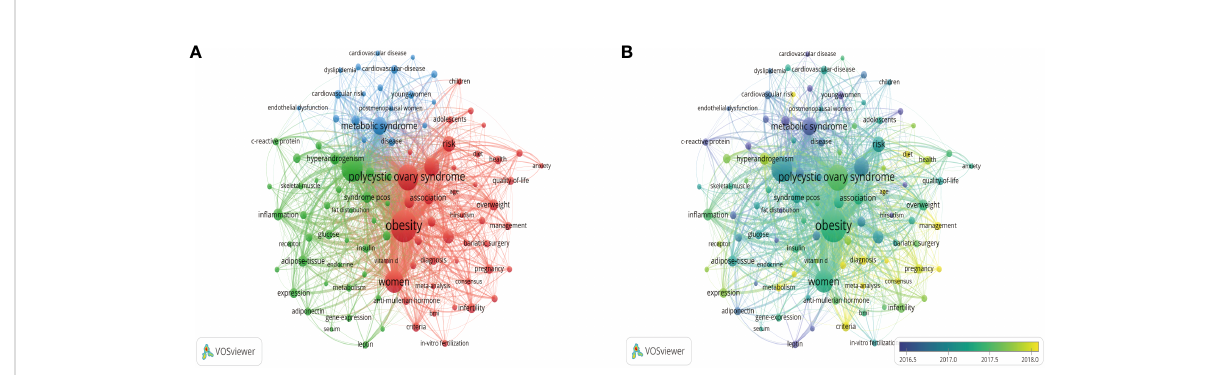
FIGURE 8 Visualization map of keywords. (A) Network diagram of the top 100 keywords. (B) Dynamics and trends of the top 100 keywords.